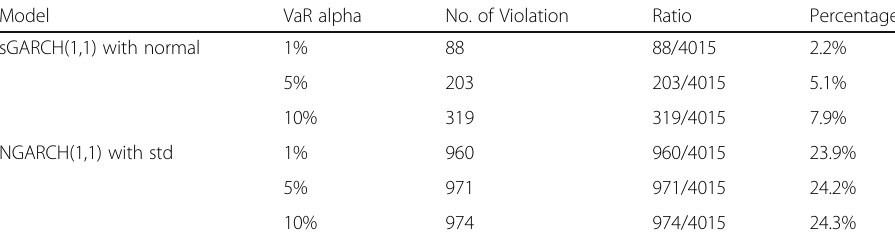
NGARCH(1,1) with